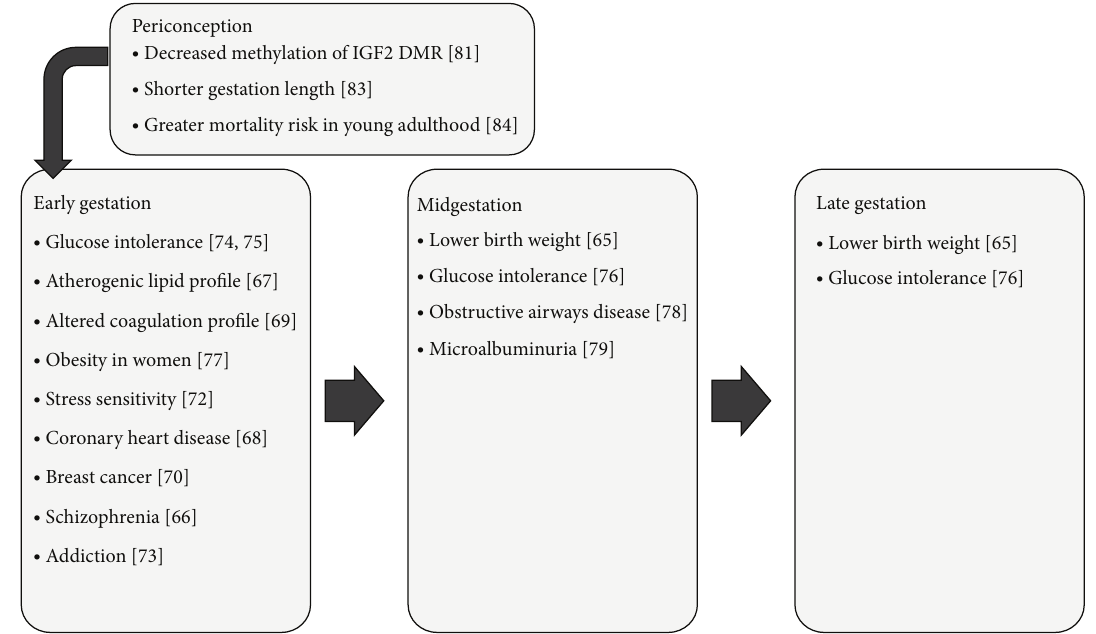
Figure 1: Conditions found at higher rates among cohorts exposed to maternal undernutrition during different periods of gestation (Dutch Famine and Gambian